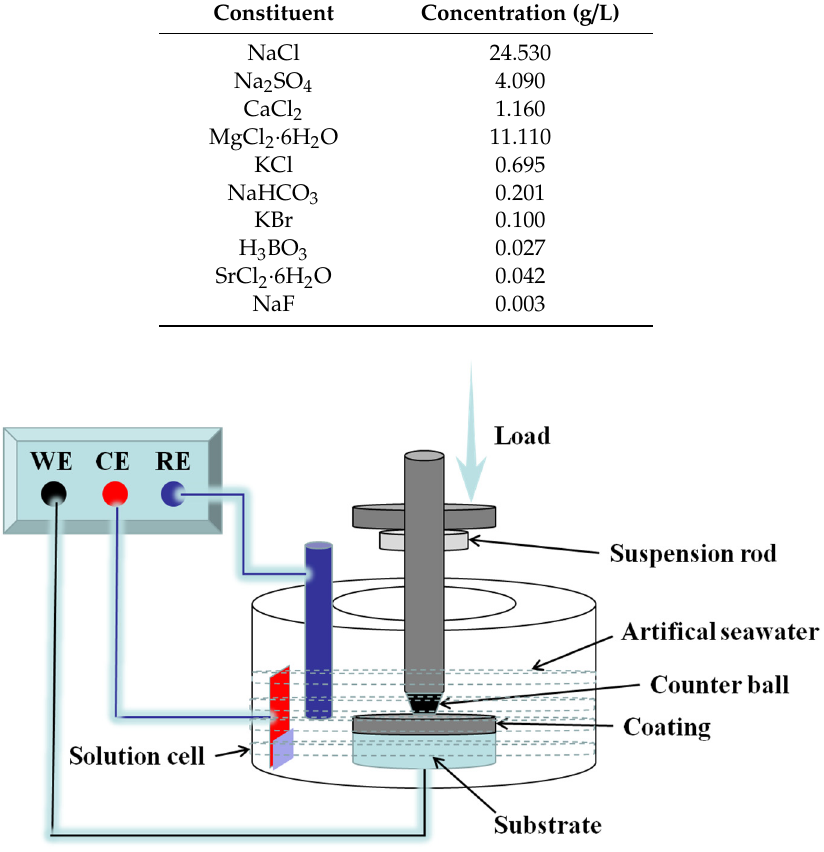
Figure 1. Schematic diagram of the reciprocating ball-on-disc tribometer.